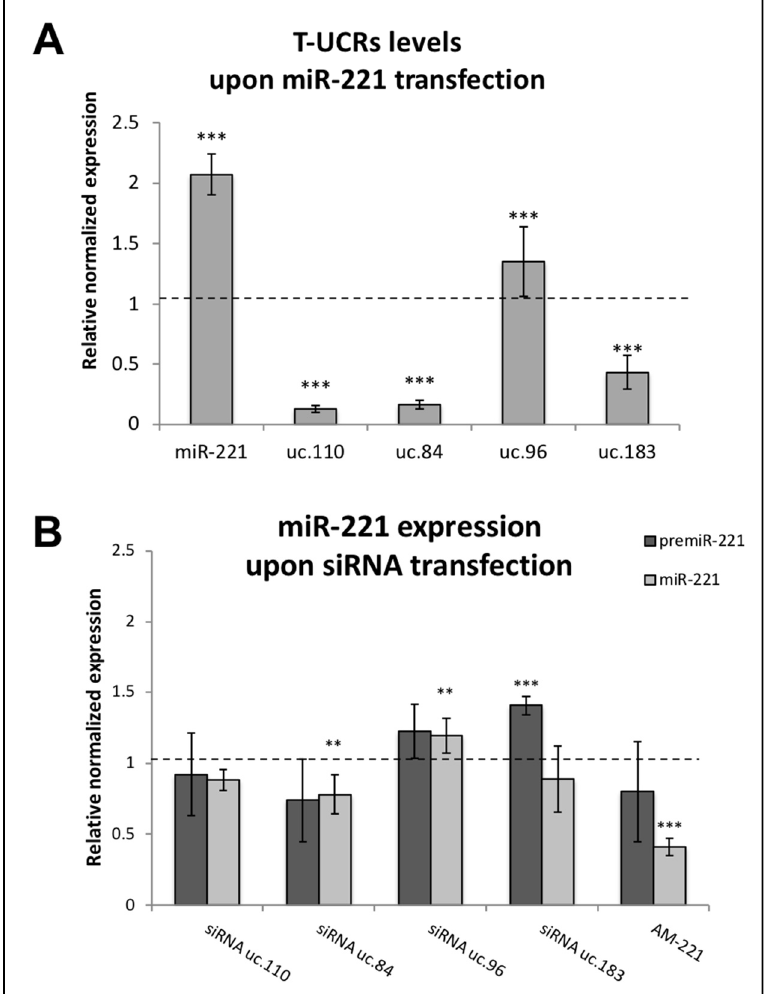
Figure 3. Effects of downregulation of T-UCRs or miR-221 in MCF-7 cells. RT-qPCR analysis of T-UCRs and miR-221 levels. ( A ), transfection using miR-221 mimic molecule and evaluation of T-UCRs expression; ( B ), transfection using T-UCR siRNAs and evaluation of pre-miR-221 and miR-221. The relative expression was normalized on the mock transfection and calculated as 2 −∆∆ Cq . Values reported are the means of 4 experiments ± SEM. Statistical significance was determined by unpaired two tailed Student t -test. p -values < 0.01 (**), p -values < 0.001 (***).